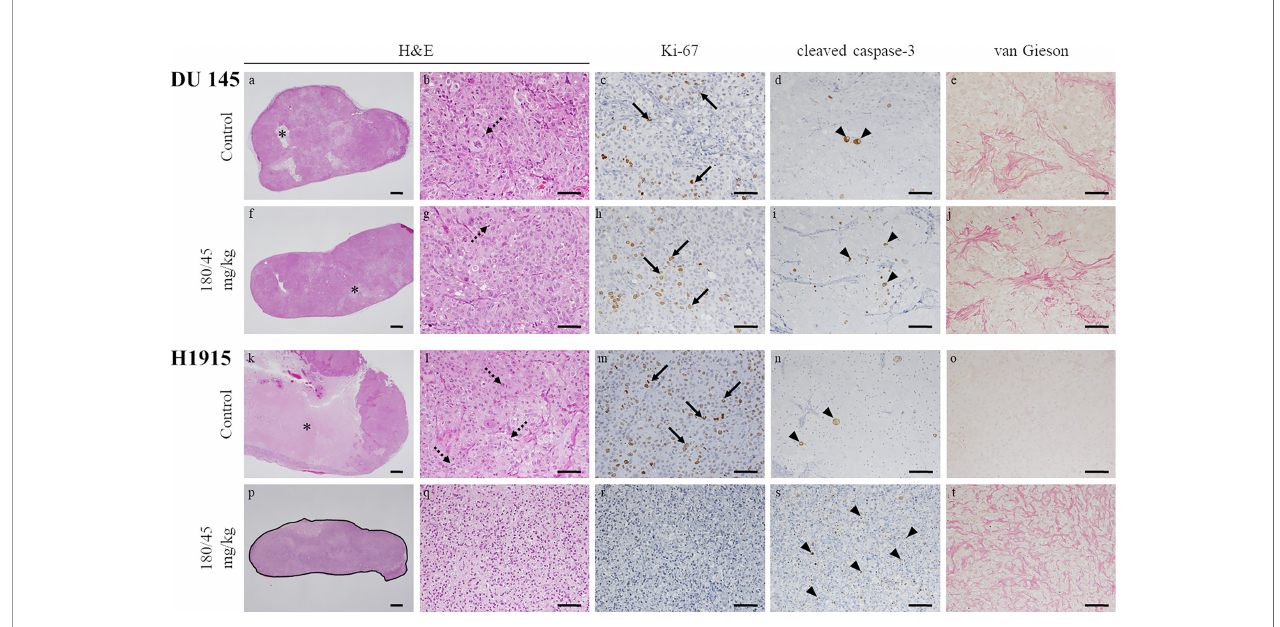
FIGURE 5 | Morphological changes in subcutaneous tumor xenografts evoked by oral administration of perifosine. The resected tumors in Figures 4C , H were analyzed by H&E staining, immunohistochemical staining for Ki-67 and cleaved caspase-3, and special staining for van Gieson. Representative images of the DU 145 (A – J) and H1915 (K – T) -tumor tissues treated with vehicle (A – E, K – O) and perifosine (F – J, P – T) are shown; scale bar = 500 m m (A, F, K, P) or 50 m m (B – E, G – J, L – O, Q – T) . Granulomatous legion is delineated by a solid black line (P) . Perifosine induced granuloma formation around the H1915 tumor lesion (P) . Necrosis (asterisks), mitotic fi gures (dotted arrows), Ki-67-positive cells (arrows), and cleaved caspase-3-positive cells (arrowheads).